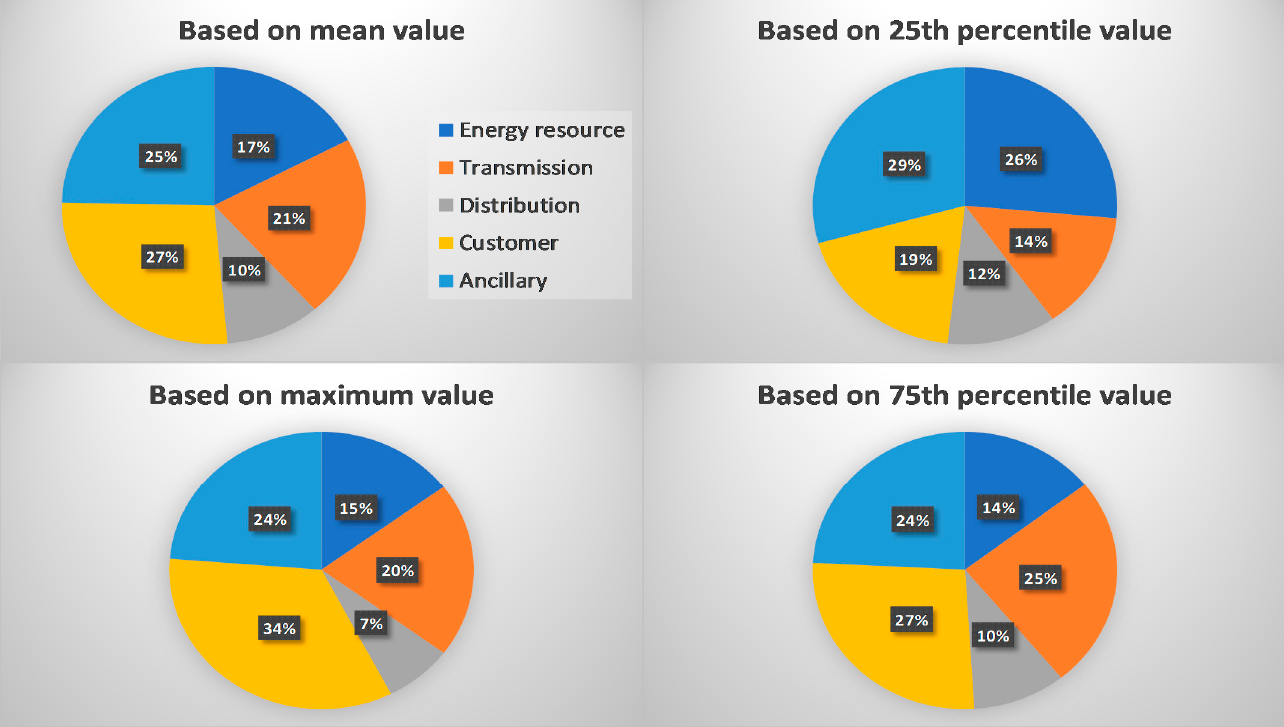
Figure 3. Percentage life cycle energy storage and saving by BESS in various services in a whole distributed energy system.